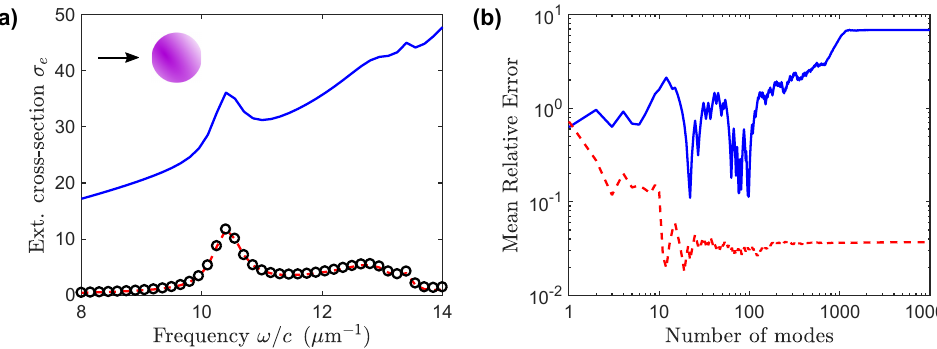
Figure 4. Convergence of the QNM expansion for a dielectric sphere with a Lorentz permittivity. ( a ) Spectrum of the extinction cross-section normalized by the sphere apparent surface π R 2 . The results obtained with the QNM expansion formed with all modes shown in Figure 3a (blue curve) are compared with the results of a direct FEM calculation (black circles). The red dashed curve displays the results obtained with a QNM expansion that excludes the 1786 static modes shown in Figure 3c. ( b ) Mean relative error as a function of the number of modes retained in the QNM expansion. With the static modes calculated with the QNM solver (blue curve) and without them (red dashed curve). The results of a direct FEM calculation with the same mesh are taken as a reference and the relative error is averaged over the spectral range of ( a